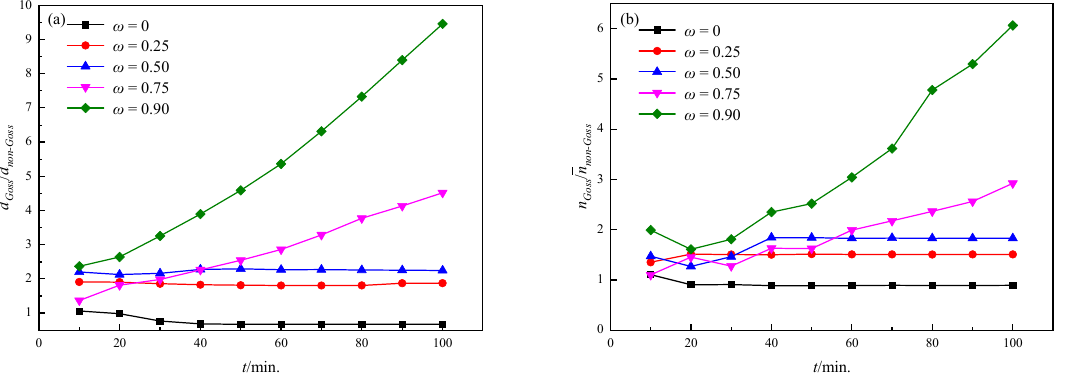
Figure 11. The quantitative characterization of abnormal growth levels under different ω s: ( a ) the size ratio of Goss grains to non-Goss grains; ( b ) the side ratio of Goss grains to non-Goss grains.